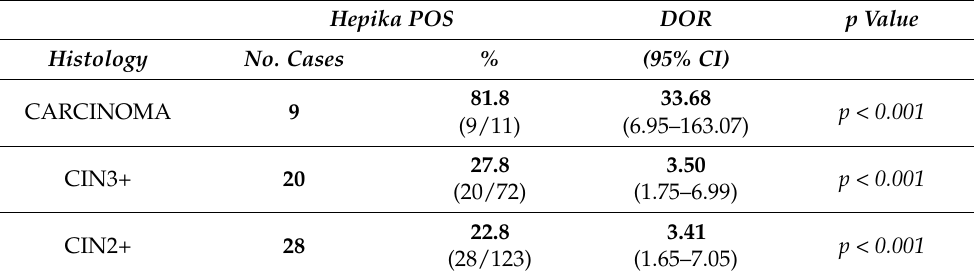
Table 6. Relationship between Hepika test and severity grade of cervical